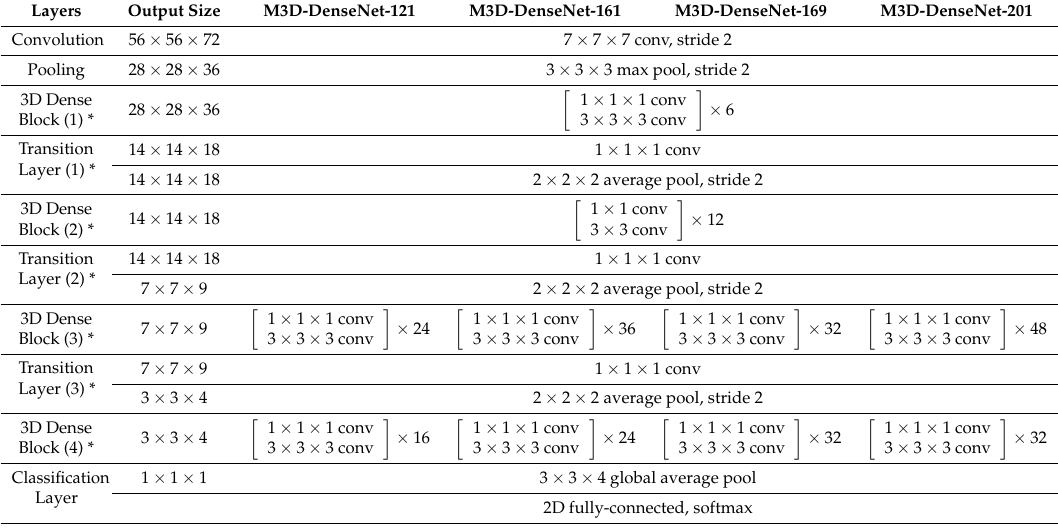
Note: The growth rate parameter of 3D DenseNet is set to 32. Each conv layer shows in the table represents the layer sequence BN ‐ ReLU ‐ Conv (BN: batch normalization layer, ReLU: rectified linear unit activation layer, Conv: convolutional layer). * Numbers refer to Figure 2, 3D Dense Block 1, 2, 3 and 4, respectively.